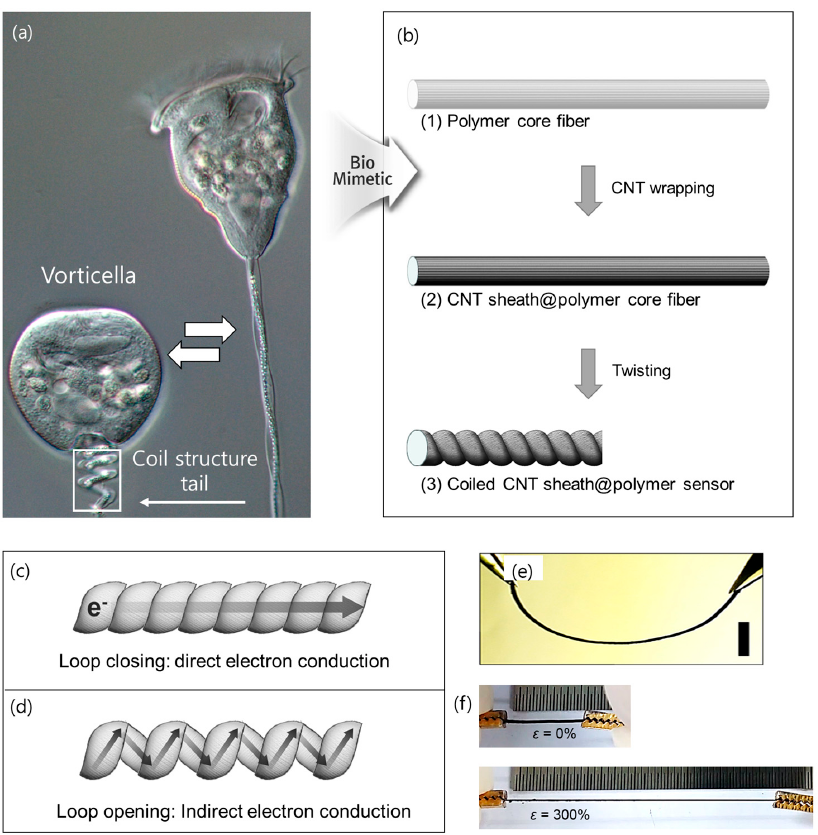
Figure 1. Morphology and electron transfer mechanism for the coiled carbon nanotube (CNT)/polymer fiber ( a ) Photograph showing Vorticella before ( left ) and after body stretching ( right ) via the loop opening of the coil-structured tail. ( b ) Schematic of biomimetic strategy for the fabrication of coil-structured CNT/polymer fibers. (1 and 2) The CNT sheath is being wrapped around the core fiber; (3) the fiber is twisted many times to coil the fiber. The electron transfer mechanisms in the coil fiber-based sensor are compared: ( c ) (initial state) direct electron transfer through the closed loops, and ( d ) (stretched state) indirect electron transfer along the coil helix through the opened loops. ( e ) Photograph shows the bending of coiled CNT/polymer fiber sensor with tweezers. ( f ) Photographs of coiled CNT/polymer fiber sensor (initial length: 1 cm) before ( above ) and after ( below ) 300% strain application (final length: 4